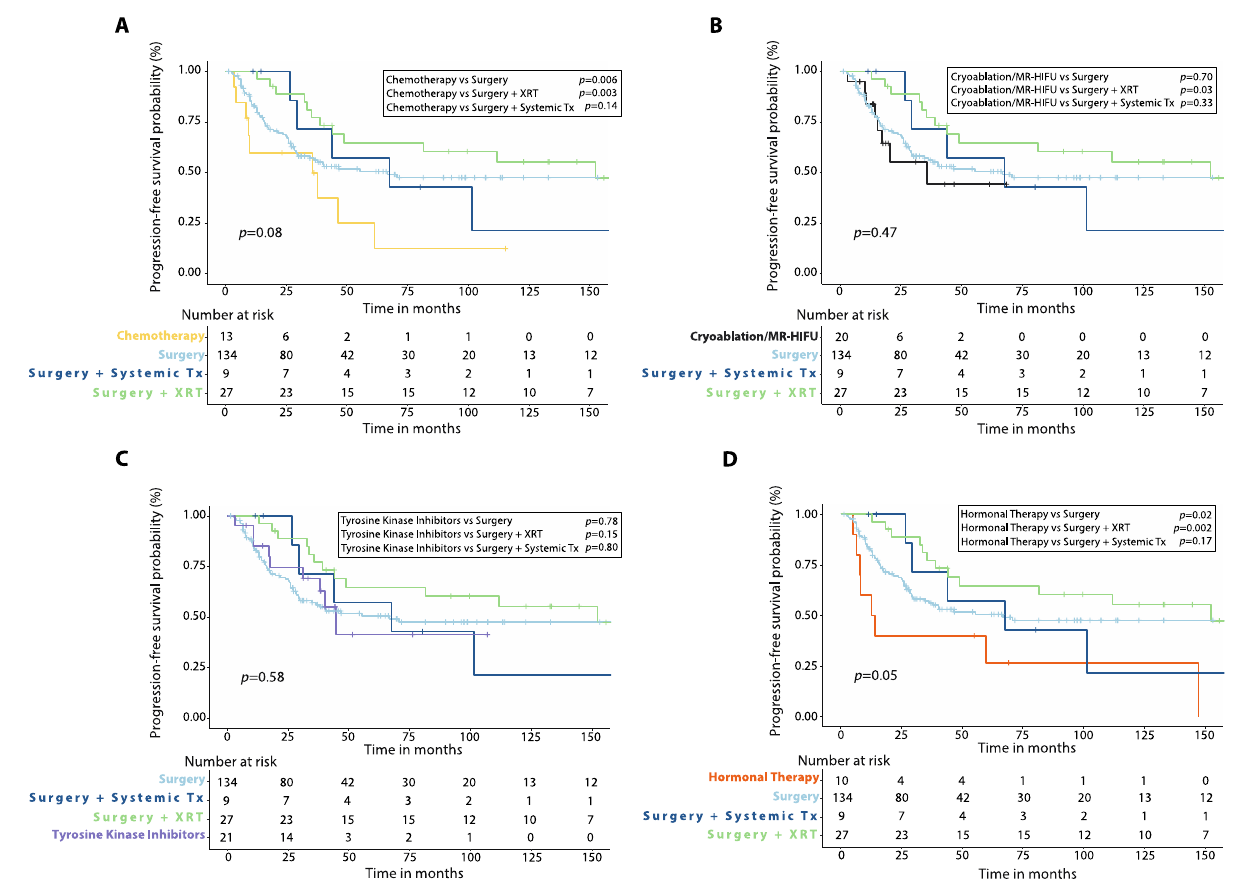
Figure 1. Progression-free survival (PFS) after first-line treatment in patients with desmoid tumors. Kaplan–Meier curves show comparison of PFS between patients treated with first-line chemotherapy ( A ), cryoablation or MR-HIFU ( B ), tyrosine kinase inhibitors ( C ), or hormonal therapy ( D ) versus surgery alone, surgery plus adjuvant radiotherapy (XRT) or surgery plus adjuvant systemic therapy. p ‐ values were calculated with the Log ‐ Rank method. XRT: radiotherapy; Systemic Tx: Systemic therapy; MR ‐ HIFU: Magnetic resonance ‐ guided high intensity focused ultrasound; Surgery plus systemic therapy includes surgery plus adjuvant chemotherapy, surgery plus adjuvant hormonal therapy and surgery plus imatinib.